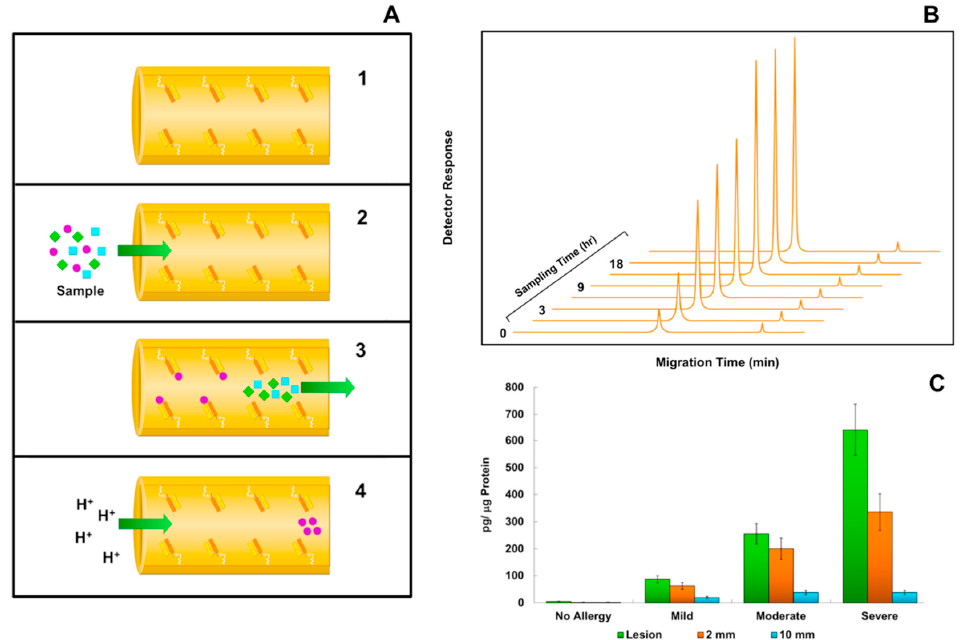
Figure 2. Schematic representation of a fritless ACM device without the presence of a matrix composed of beads, sol-gel, or monolithic materials utilized in conventional capillary electrophoresis or microchip capillary electrophoresis. Immobilization of the a ffi nity ligands occurs directly onto the inner wall of the ACM device ( A ). The protocol for sample processing is shown in four steps: (1) covalent immobilization of an antibody, directed against brain-derived neurotrophic factor (BDNF) neuropeptide used as a ffi nity capture material, directly to the inner wall of a microchip channel (alternatively, 2-mm glass beads immobilized with streptavidin to which a biotinylated antibody against BDNF is coupled, can be inserted into the main channel of the microchip or in an immunoa ffi nity port of a specially designed microchip); (2) binding of immunoreactive BDNF neuropeptide present in skin biopsies to the immobilized a ffi nity capture antibody; (3) cleaning excess amounts of unwanted non-specifically-bound material and equilibration of the capillary system; (4) elution of the reversibly specifically-bound BDNF neuropeptide. ( B ) Depicts the sequential IACE electropherograms of BDNF concentrations present in skin biopsies taken at di ff erent time points in a patient with severe atopic dermatitis illustrating the concentrations of detectable BDNF over time. Graph ( C ) illustrates the concentrations of BDNF in skin biopsy of a patient with severe atopic dermatitis and control groups measured by IACE at 18 h post-initial onset of the reaction. The green color bars represent the amount of BDNF measured within the lesion, while the orange color bars represent the background amounts of BDNF measured in tissues taken 2 mm from the periphery of the lesion. The light blue-colored bars represent the amount of background BDNF measured in tissue taken 10 mm from the periphery of the lesion. All values are the mean ± S.E.M. Figure modified from